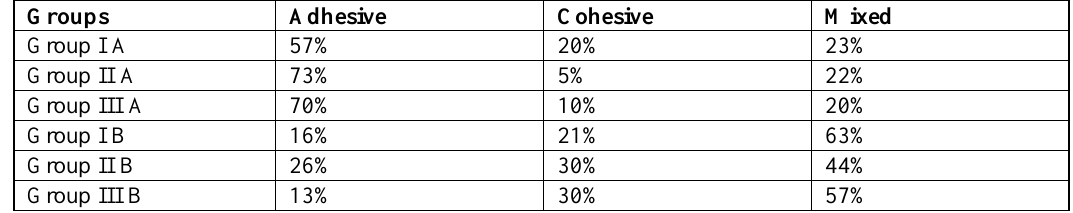
Table 4: failure mode for different